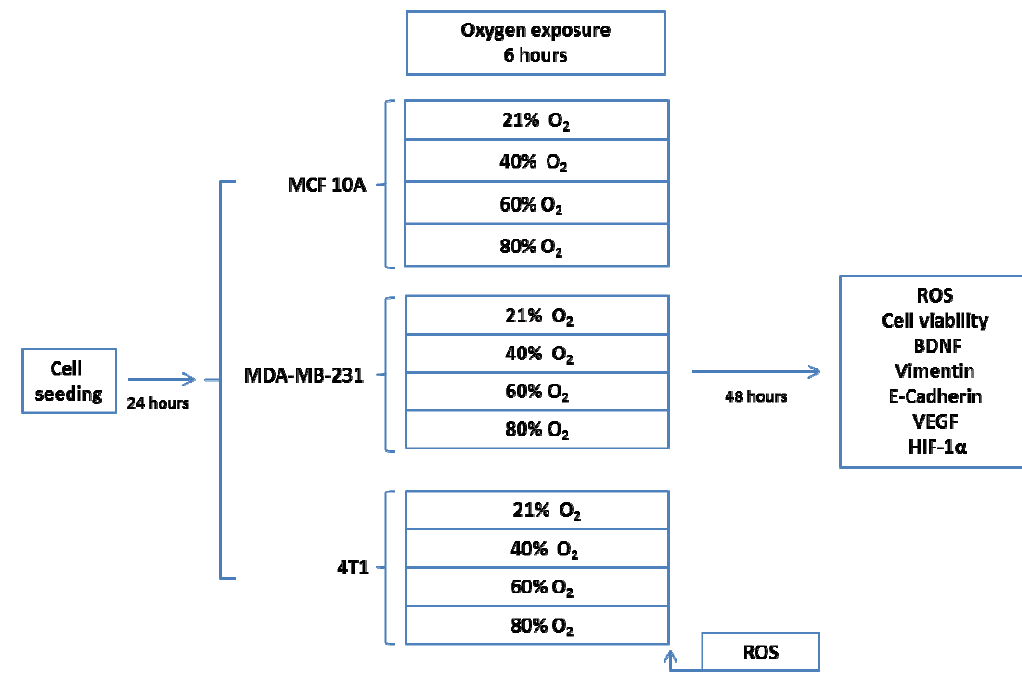
Figure 1. In vitro experimental protocol.